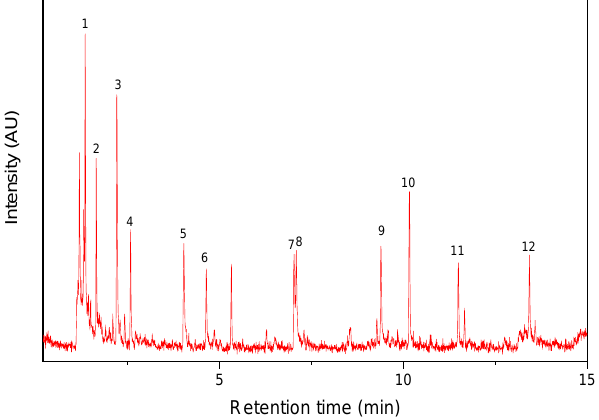
Figure 1. Py-GC/MS chromatogram of the PM 10 sample.